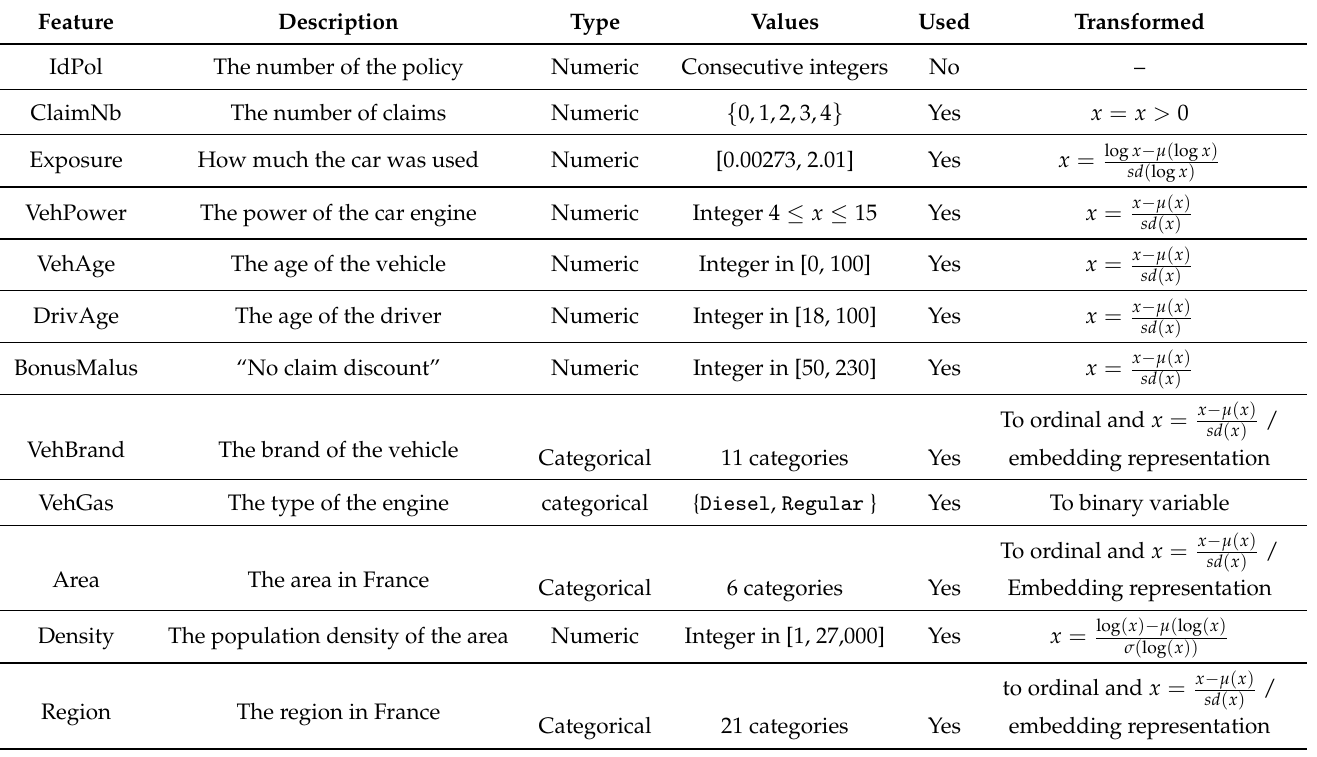
Table 1. Summary of the data features and the corresponding preprocessing methods.